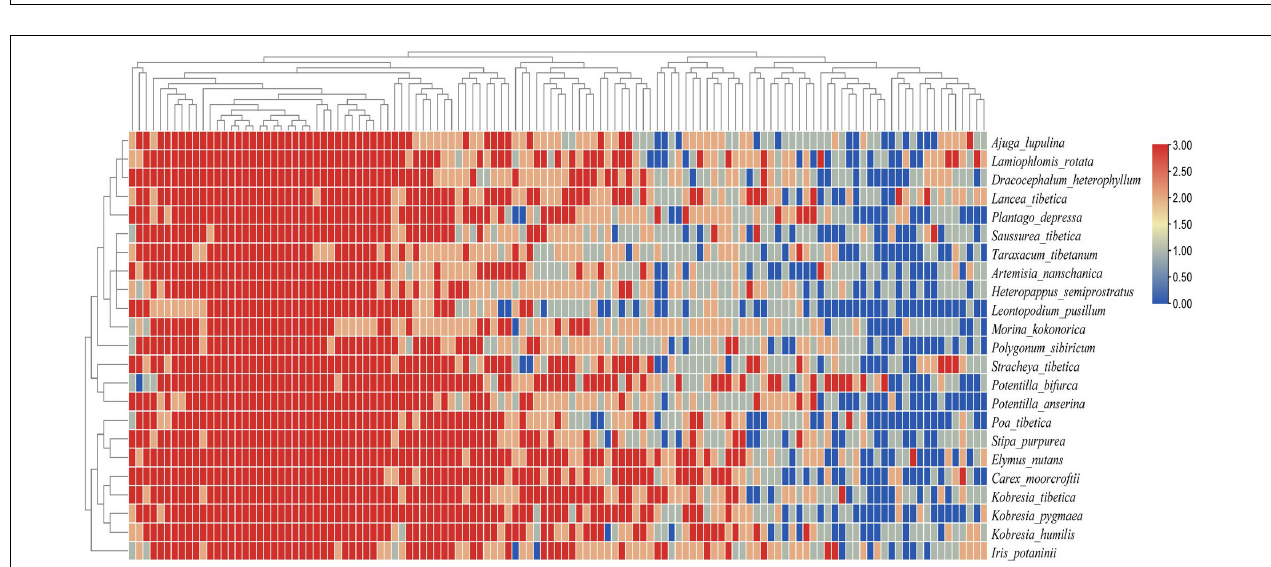
FIGURE 5 | Relationships between the phylogenetic distance of 23 plant species and their corresponding AMF taxonomic (A) and phylogenetic (B) community dissimilarity tested by linear regression and mantel test.